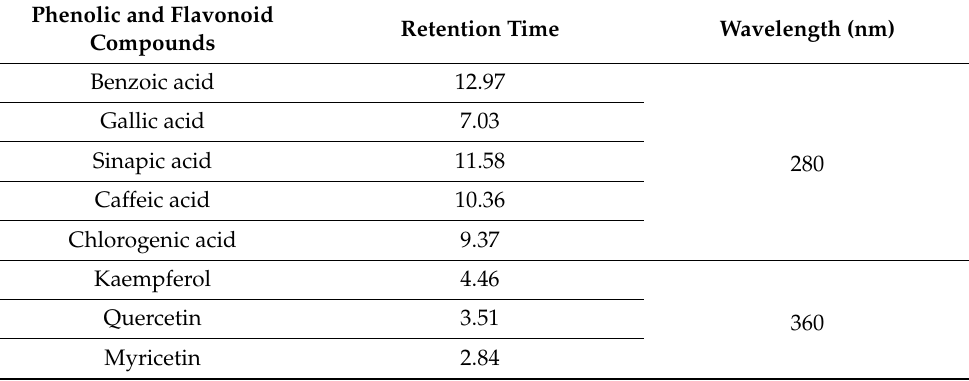
Table 3. Standard flavonoid and phenolic compounds determined by the HPLC